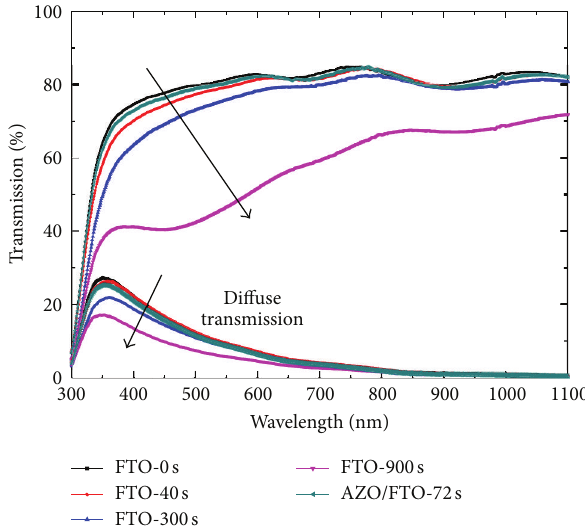
Figure 1: Effect of H 2 -plasma treatment time on optical transmis- sion of FTO and AZO/FTO